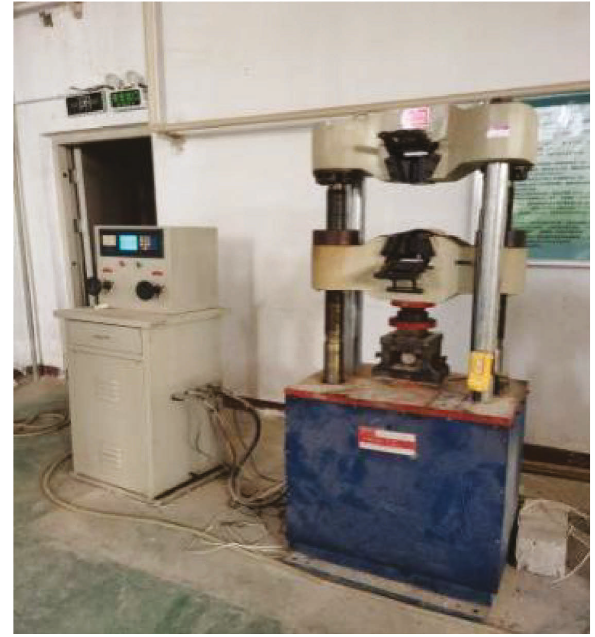
Figure 6: Universal material testing